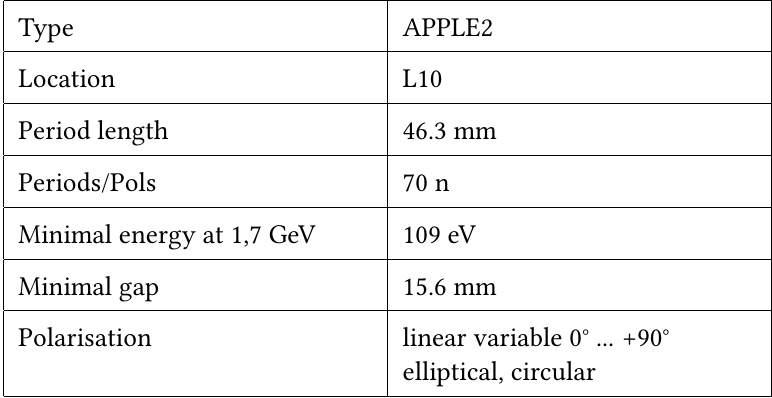
Table 1: Parameters of insertion device